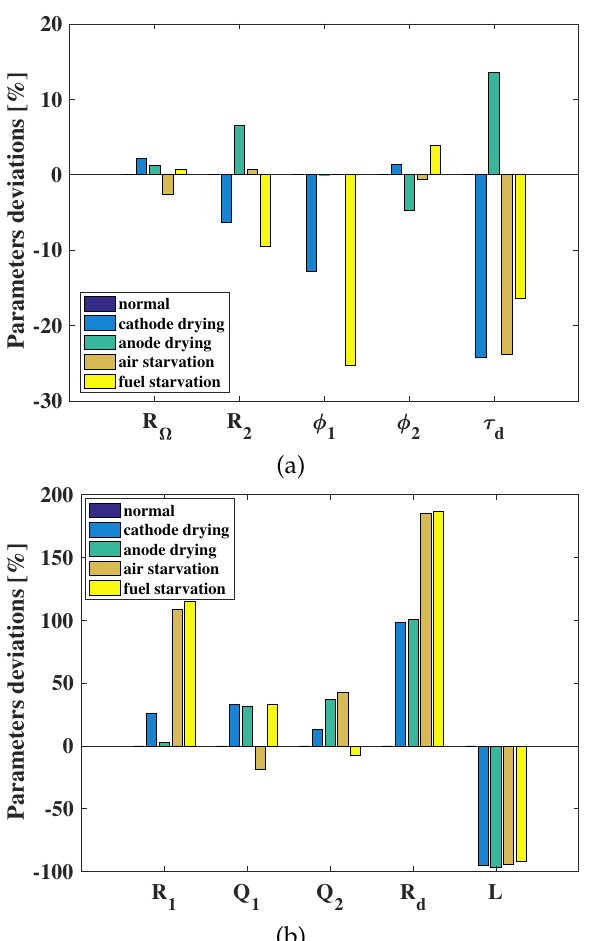
Figure 13. Parametric variations due to the analyzed faults. ( a ) Parameter with small variation. ( b ) Parameters with large